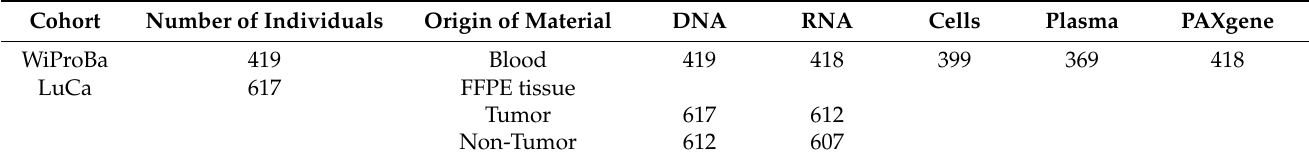
Figure 7. Overview of the available biomaterial stored in the German Uranium Miners’ Biobank (GUMB) located at the BfS. FFPE tissue is still available in the pathological archive stored by the IPA. Table 1. Available biological material of individuals in WiProBa and LuCa.